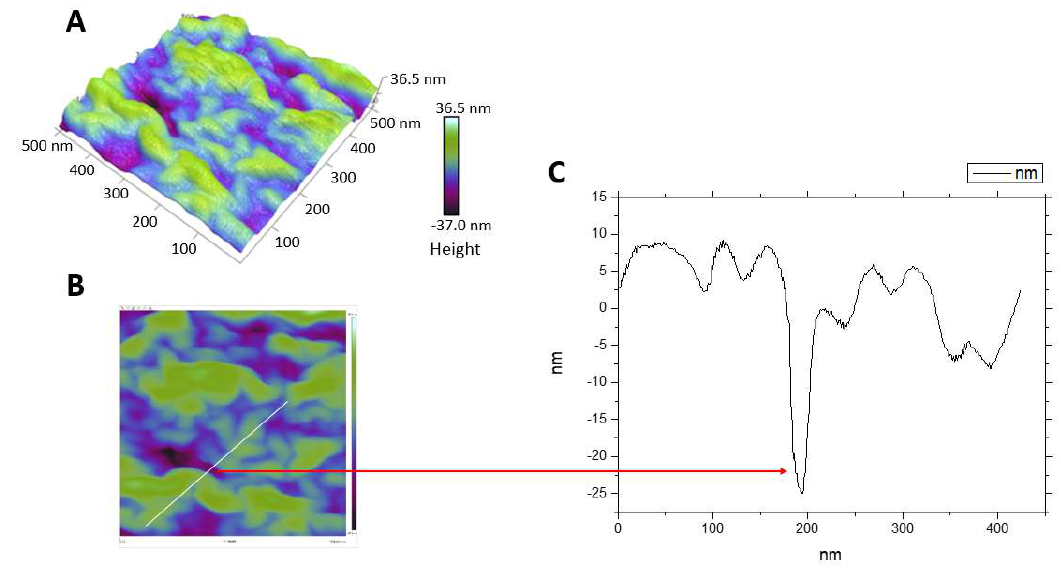
Figure 5. The topology of mastoparan-AF treated-hemolytic E. coli O157:H7 analyzed by AFM. ( A ) Two-dimensional (2D) and ( B ) three-dimensional (3D) images show smooth cell surfaces of untreated hemolytic E. coli O157:H7. ( C ) A 2D image of mastoparan-AF (32 μg mL −1 )-treated hemolytic E. coli O157:H7. Abnormal perforations and dents on the surface of bacteria are indicated by arrows and arrowheads, respectively. The 3D images focusing on two highlighted areas of ( C ), respectively, reveal ( D ) a rough cell surface and ( E ) a hollow tube resulting from perforations at apical ends. ( F ) A 3D image shows a mastoparan-AF-treated bacterium with a budding vesicle. ( G ) A 3D image shows mastoparan-AF-treated bacteria with a wrinkled or rough surface. ( H ) Magnification of portion of ( G ) displays, in high resolution, the surface roughness of a mastoparan-AF-treated bacterium.